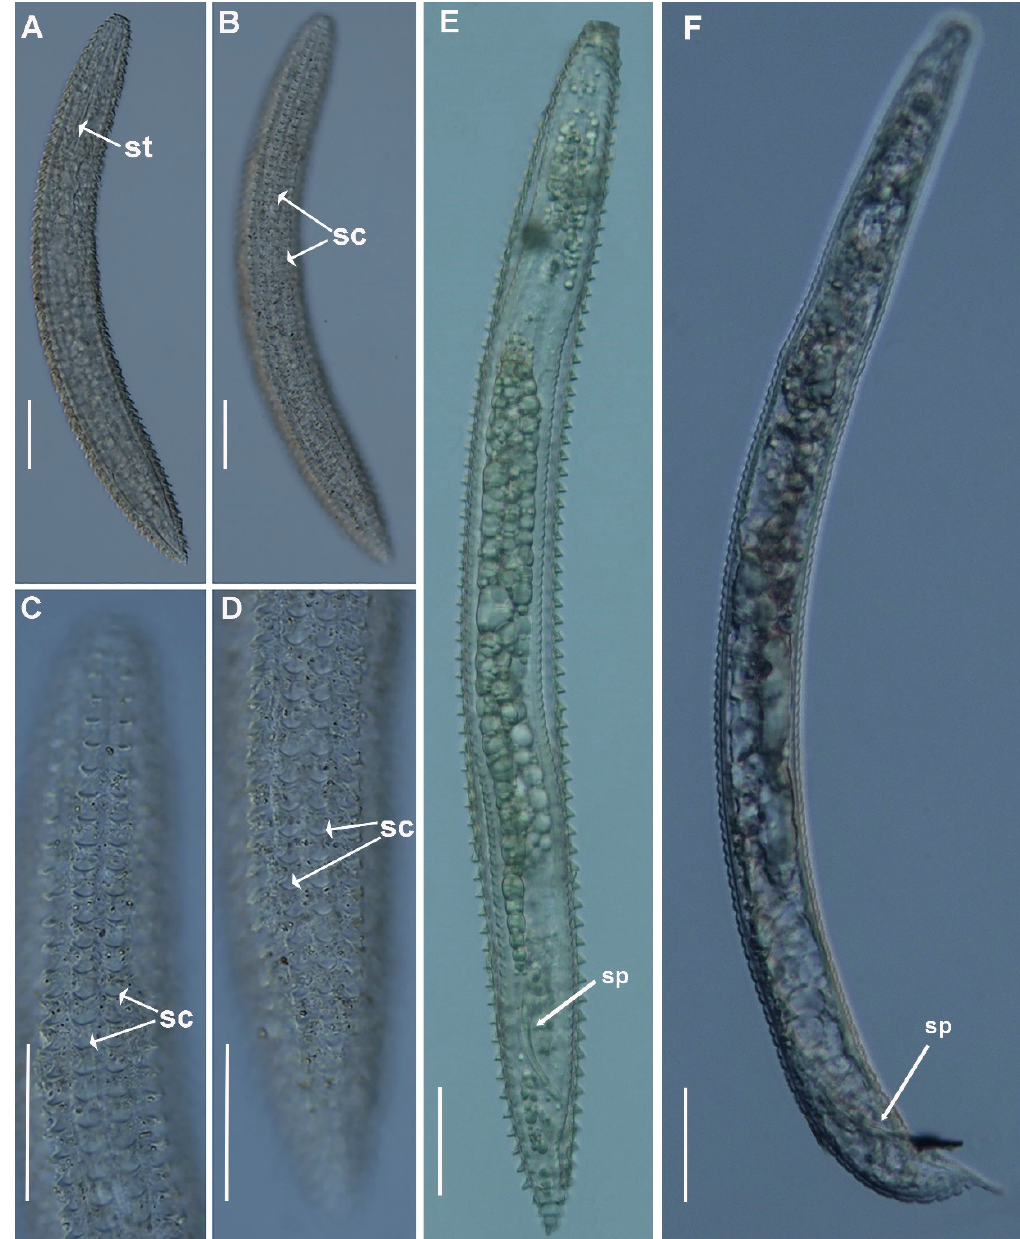
Figure 9. Light micrographs of Criconema plesioannuliferum sp. nov. juveniles and male. ( A , B ), whole juvenile, showing stylet and rows of scales (arrowed); ( C ), anterior region, showing rows of scales (arrowed); ( D ), posterior region showing rows of scales (arrowed); ( E ), whole male included in fourth-stage cuticle, showing spicules (arrowed); ( F ), whole male showing spicules (arrowed). Abbreviations: sc = scales; sp = spicules; st = stylet. Scale bars: ( A – D ) = 50 µm, ( E , F ) = 30 µm.